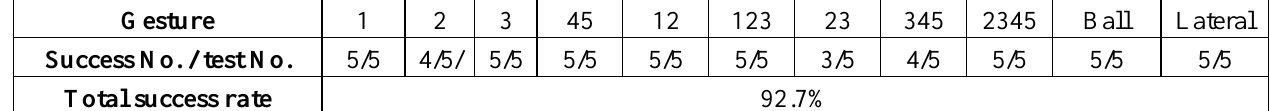
Table 7. Success rate of the 11-gesture classification of the sixth